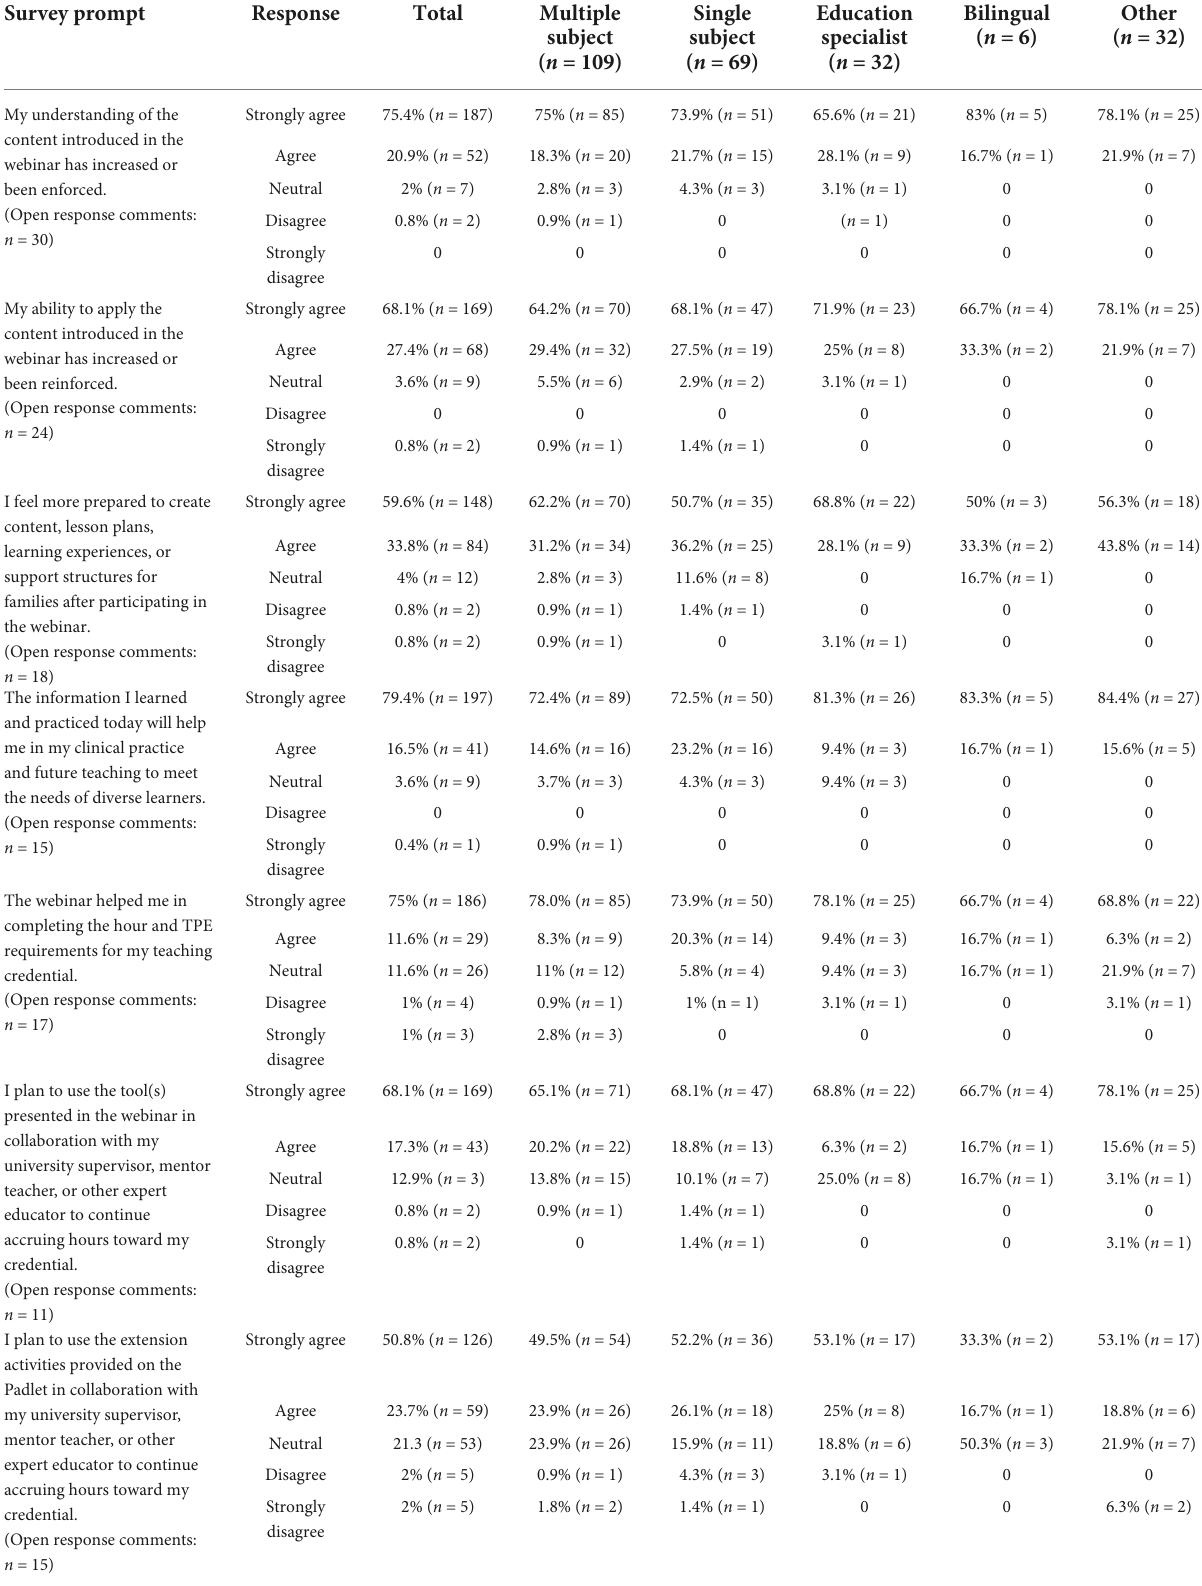
TABLE 2 Participant webinar